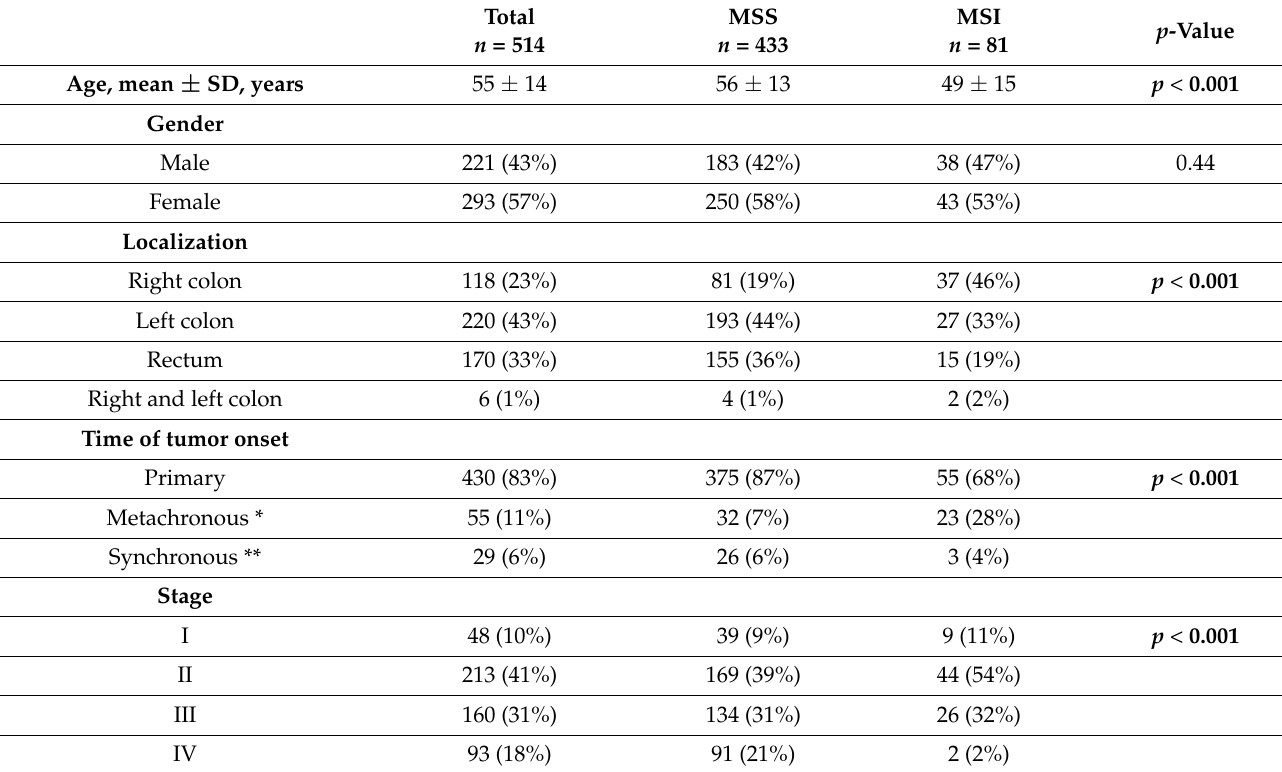
Table 1. Patient’s characteristics according to MSI/MSS